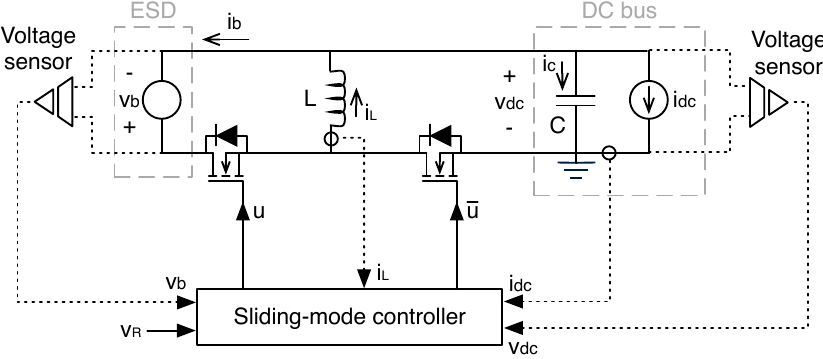
Figure 1. Buck–Boost charger–discharger connected to a